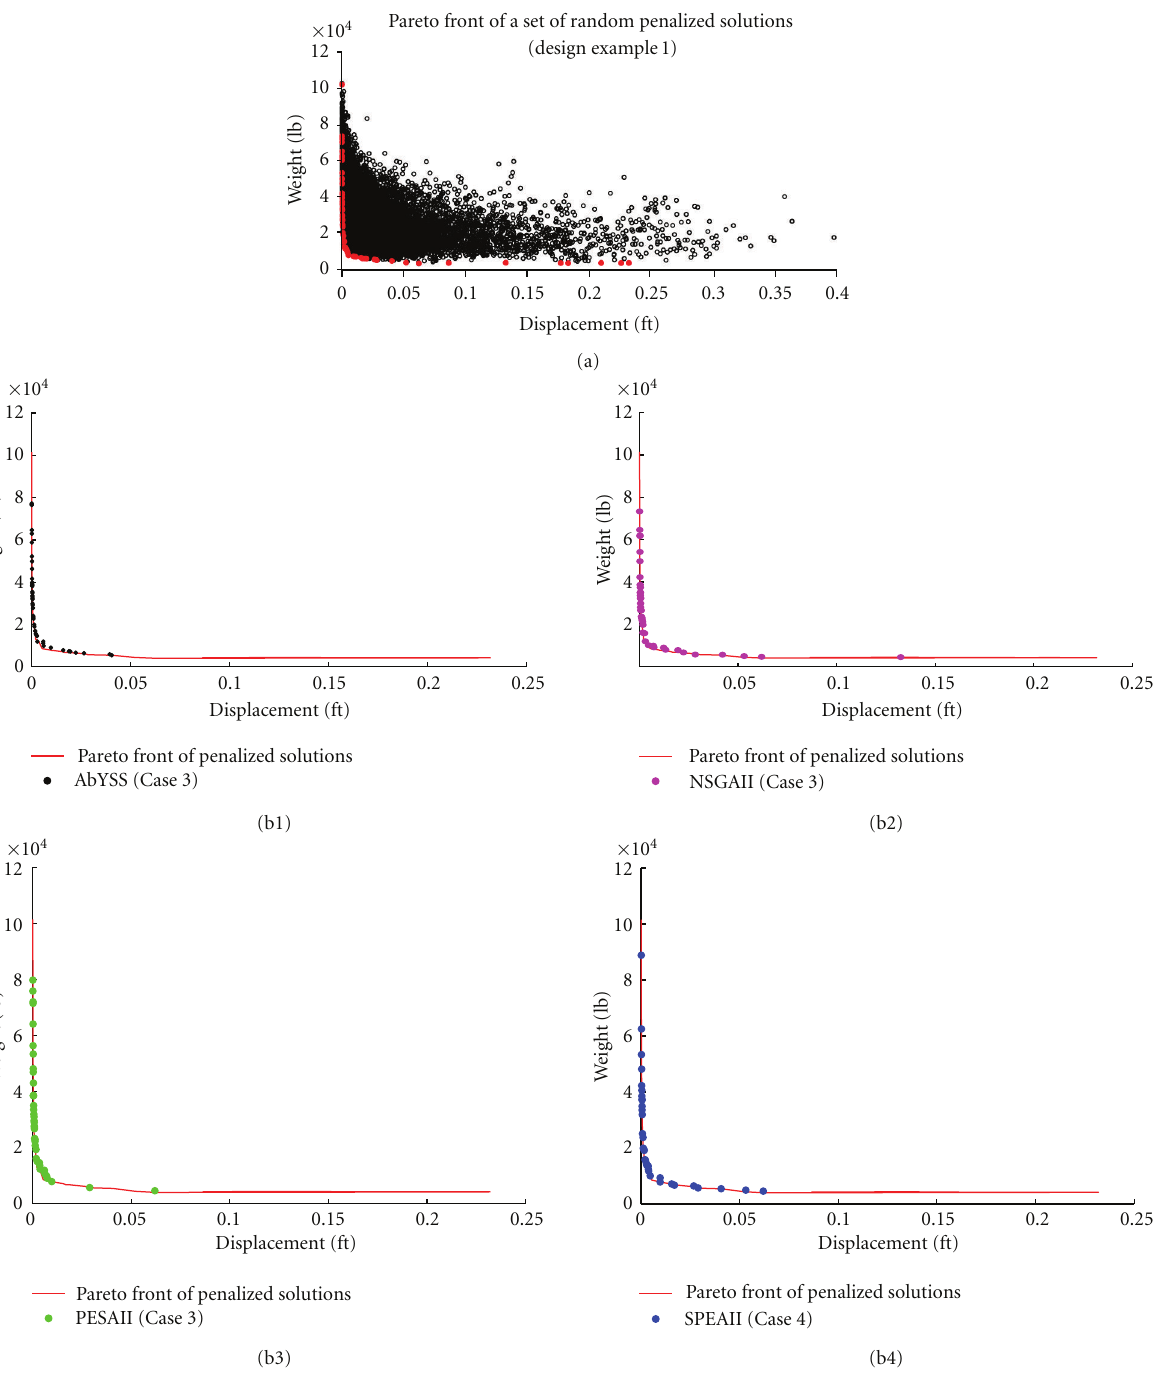
Figure 4: Pareto fronts of a set of random nondominated solutions obtained by use of an increased population size and evolution number (a) and AbYSS, NSGAII, PESAII, and SPEAII (b1)–(b4).